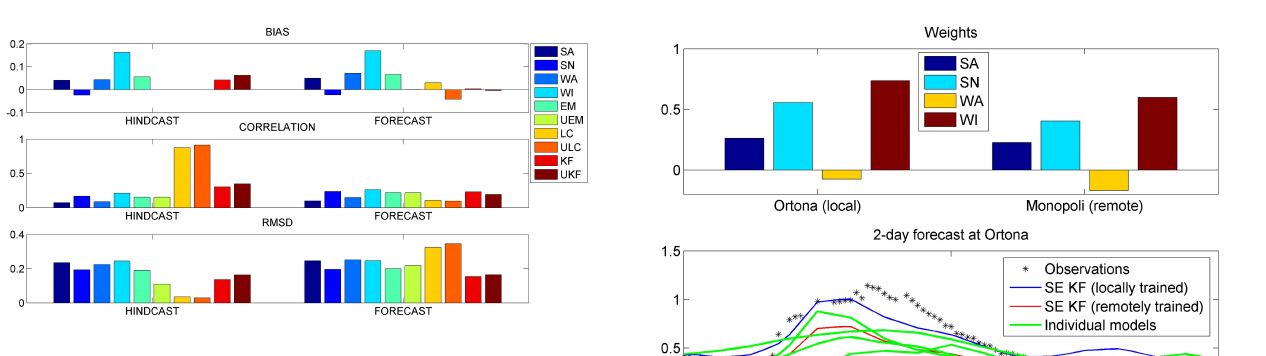
Fig. 6. Hindcast and forecast statistics of the different forecast sys- tems and the tested SE techniques, averaged over the two campaigns and all stations, using a 1-day learning period and a 1-day testing period.